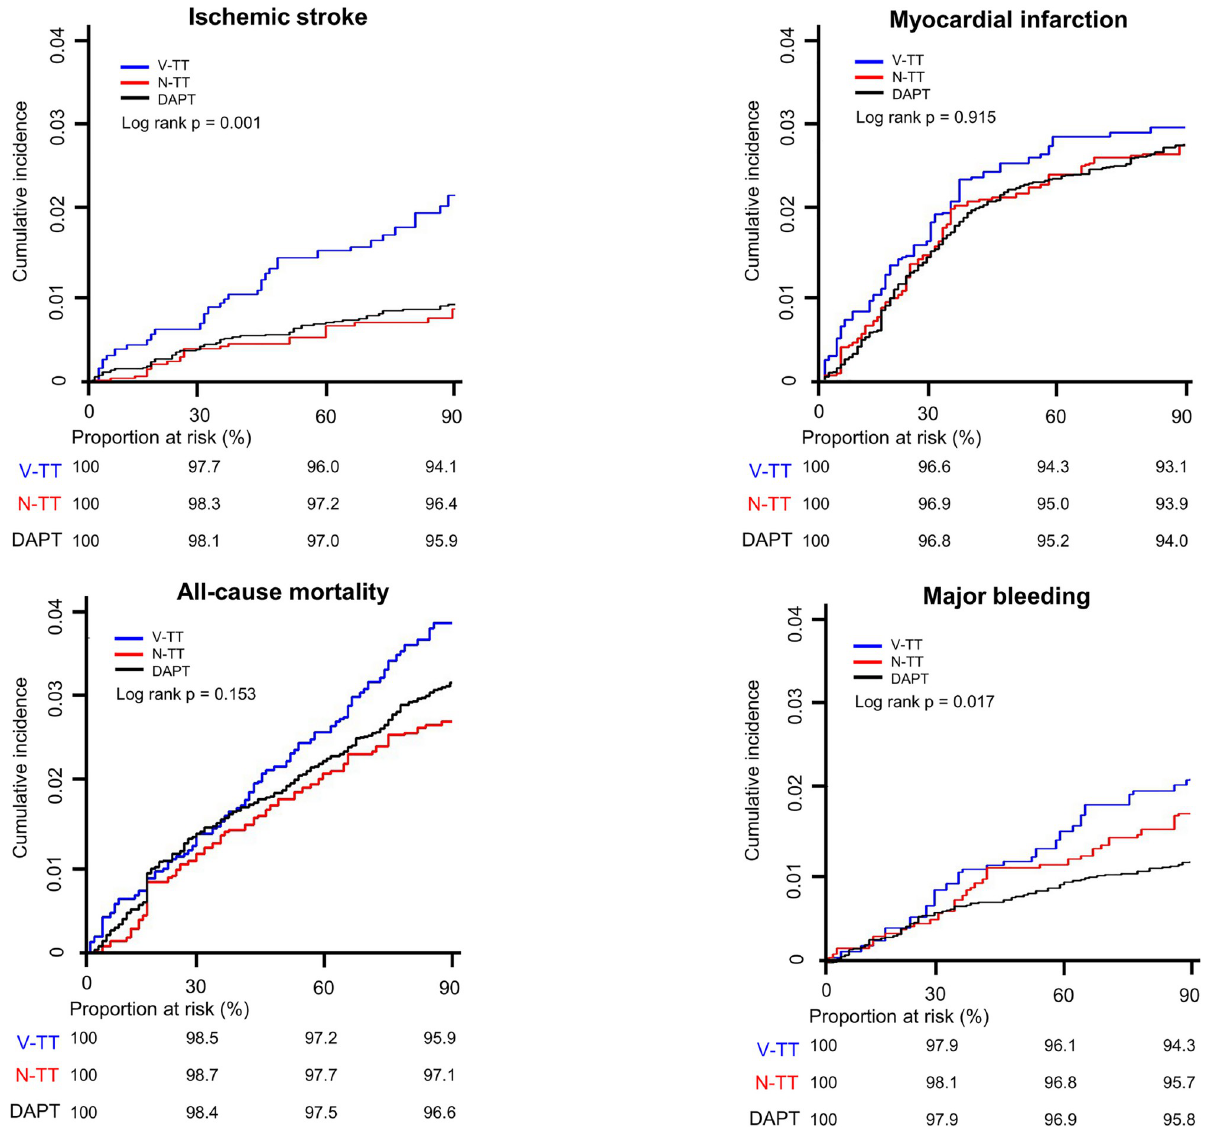
Fig 2. Weighted Kaplan-Meier curves for clinical outcomes according to antithrombotic therapy. The incidence of ischemic stroke was higher in the VKA-TT than in the NOAC-TT and DAPT groups. However, there was no difference in the incidence of all-cause mortality and non-fatal MI between the DAPT and triple therapy groups. In terms of the bleeding, the DAPT group showed a lower incidence of major bleeding than the triple therapy groups. DAPT, dual antiplatelet therapy; NOAC, non-vitamin K oral anticoagulant; N-TT, NOAC-based triple therapy; VKA, vitamin K antagonist; V-TT, VKA-based triple